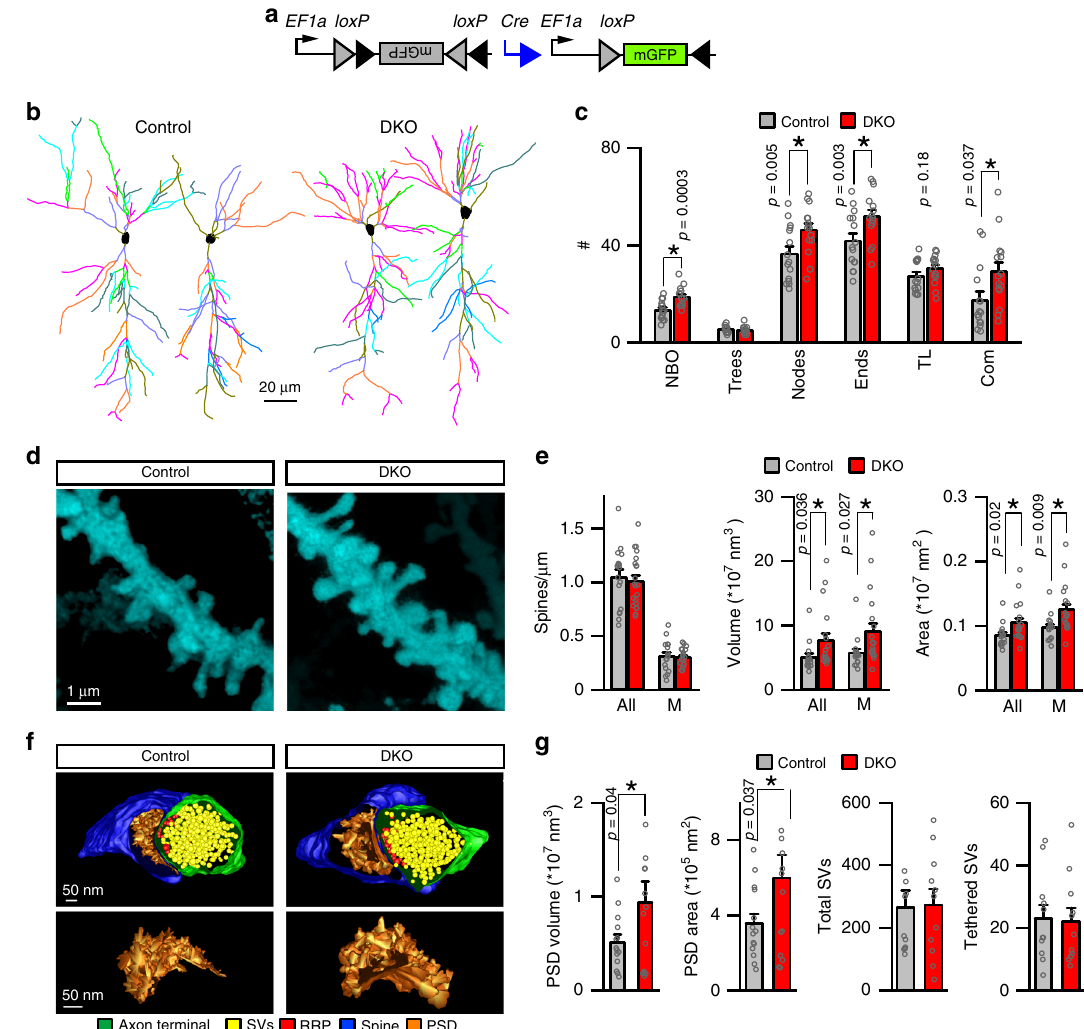
Fig. 4 Morphologies of dendrites and synapses of HDAC4/5-de fi cient excitatory neurons. a – e Pyramidal cells in the CA1 of DKO and control Emx1 IRES-Cre mice were visualized by Cre-inducible expression of membrane-bound GFP from an adeno-associated virus (AAV DJ DIO-mGFP). Animals were injected with AAVs at p45 and analyzed by confocal imaging of brain sections at p60. a Schematic diagram of AAV recombination. b 3D reconstructions of dendritic trees of individual glutamatergic neurons. c Quanti fi cations of branch orders (NBO), trees, nodes, ends, tree length (TL, μ m × 100), and complexity indexes (Com, a.u. × 10,000). Averaged values are from 3 mice/15 neurons per genotype. d Pseudo-colored images of postsynaptic spines on proximal dendrites in CA1sr. e Linear densities, surface areas, and volumes of all and mushroom (M)-type spines. Control: n = 3 mice/17 neurons; DKO: n = 3/21. f , g EM tomography analysis of architectures of glutamatergic synapses in CA1sr. f Top panels: 3D reconstructions of spines, postsynaptic densities (PSDs), nerve terminals, and synaptic vesicles (SVs). Bottom panels: isolated 3D reconstructions of PSDs. g Average volumes and surface areas of PSDs, total SV pools, and numbers of vesicles tethered to active zones (RRP). Control: n = 3 mice/14 synapses; DKO: n = 3/14. All quanti fi cations are represented as Mean± SEM. * p < 0.05 (de fi ned by t -test). Actual p -values are indicated in each